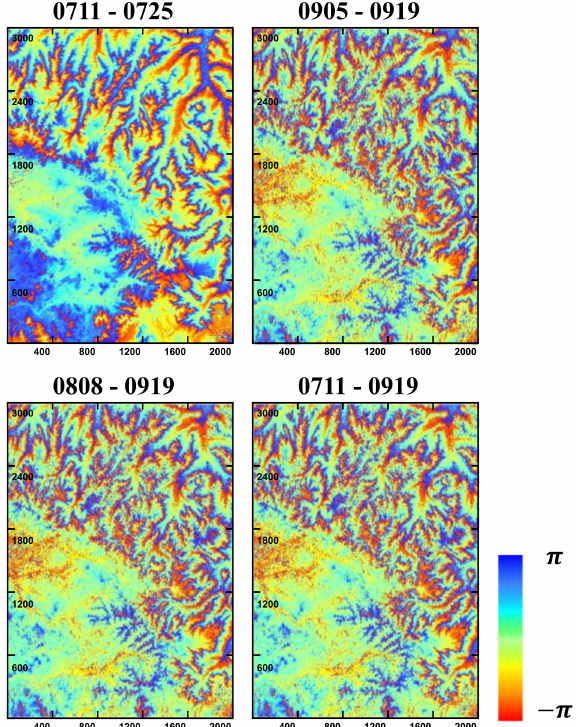
Figure 18. Phase estimation of three-stage inversion method for different interferometric pairs. There are relatively obvious phase point anomalies in the estimates of 0711-0725, which are more evident in the rugged terrain type (upper right corner). Thus, it can be demonstrated that the interferometric data with shorter spatial baselines are more prone to errors in the ground phase